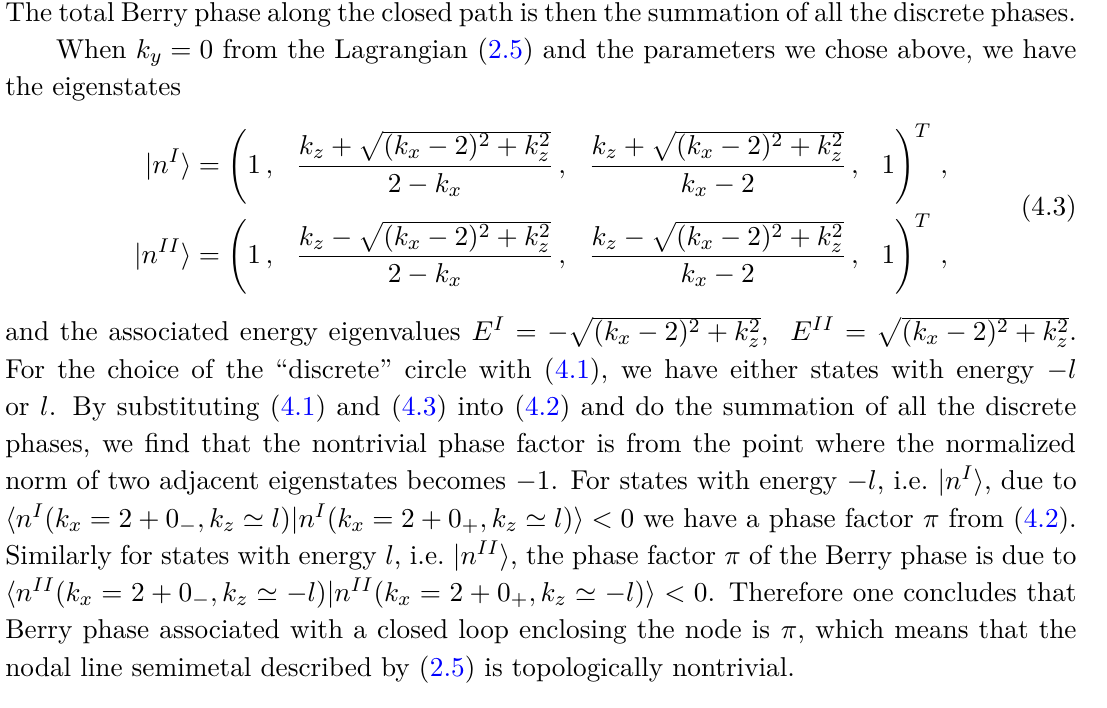
and i along the 1 2